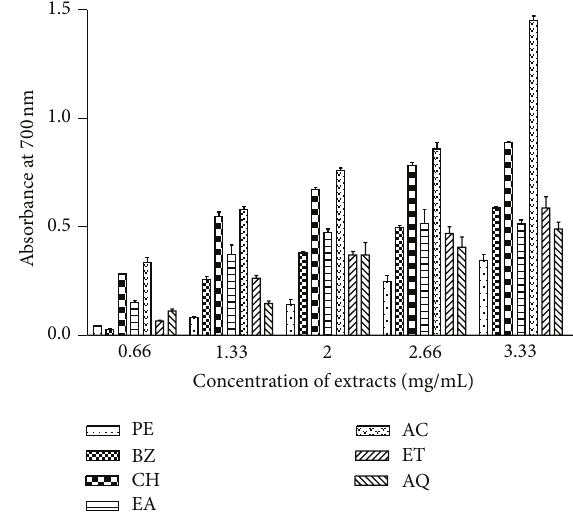
Figure 1: Reducing power of T. cordifolia stem extracts. Phytochem- icals present in sample were extracted with petroleum ether (PE), benzene (BZ), chloroform (CH), ethyl acetate (EA), acetone (AC), ethanol (ET) and water (AQ) as described in Section 2. Reducing power of extracts was measured at different concentrations (0.66– 3.33 mg/mL) and absorbance was recorded at 700 nm. The results are expressed as mean ± SD of three replicates ( 𝑃 < 0.05